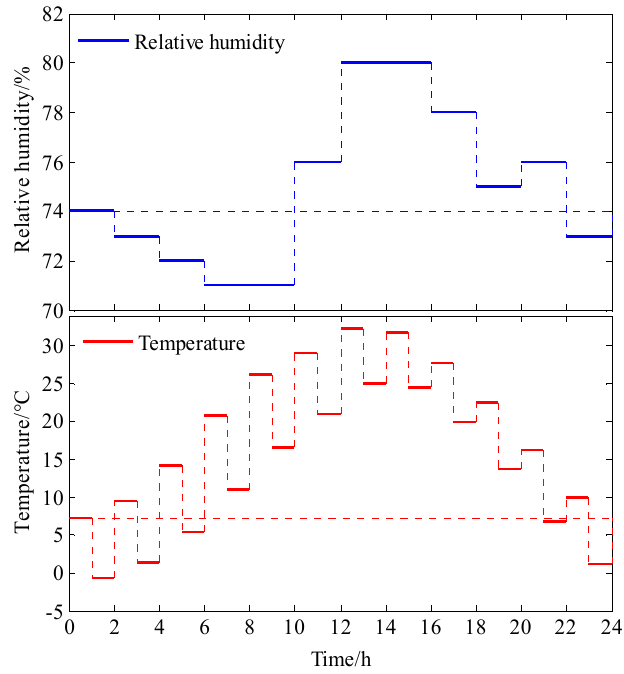
Figure 1. The periodic temperature ‐ humidity experimental parameters.